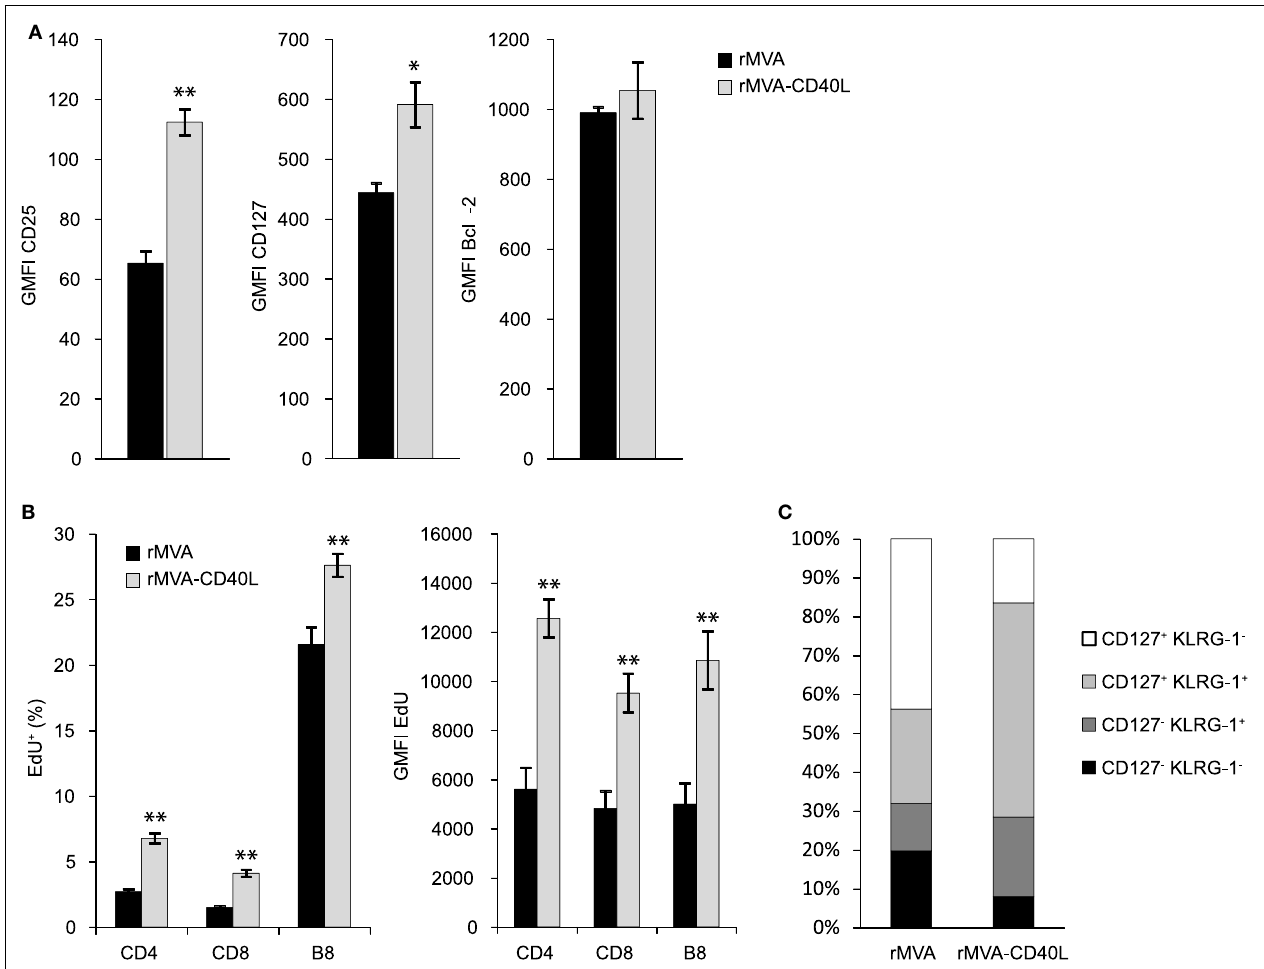
splenicT cells was determined flow cytometrically after 1h. (B) The percentage and GMFI of EdU + CD4, CD8, and B8-specificT cells are shown as the mean ± SEM. (C) depicts the relative frequencies of CD127 + KLRG-1 − , CD127 + KLRG-1 + , CD127 − KLRG-1 + , and CD127 − KLRG-1 − cells among all splenic B8-specific CD8T cells on day 7 after immunization. Data are representative of five mice per group and at least two independent